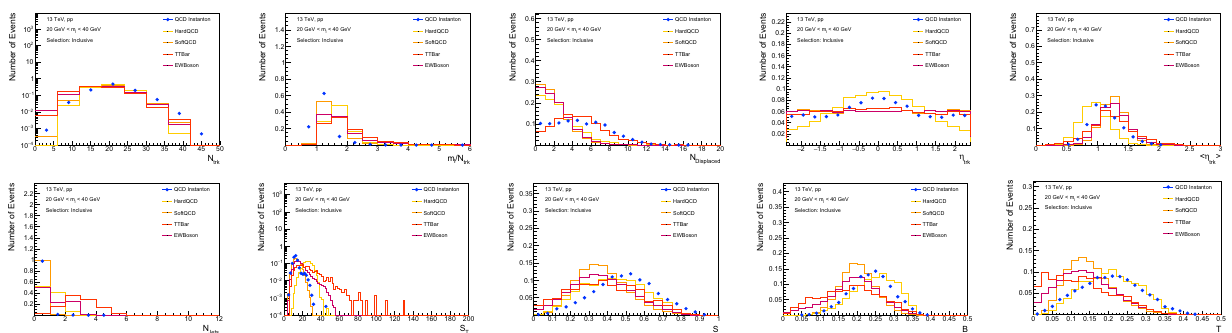
Fig. 9 Normalized distributions in the very low mass regime for various processes: N Trk , m I / N Trk , N Displaced , η Trk , (cid:7)| η Trk |(cid:8) , N Jets , S tracks